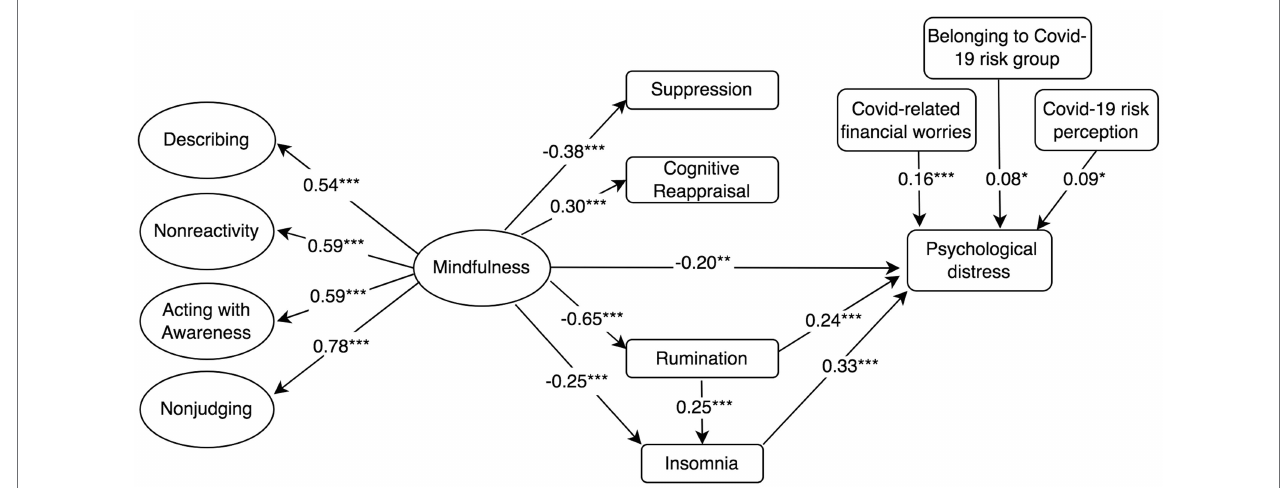
FIGURE 3 | Standardised mediation Model 3 of the effect of higher-order mindfulness on COVID-19-related psychological distress. Psychological impact of COVID-19 = IES-R, 22-item Impact of Event Scale-Revised; Rumination = RSS-SF, 10-item Rumination Response Scale-Short Form; Cognitive Reappraisal and Suppression = ERQ, 10-item Emotion Regulation Questionnaire; Insomnia = ISI, 7-item Insomnia Severity Index; and Mindfulness and facets = FFMQ-SF, 24-item Five-Facets Mindfulness Questionnaire-Short Form. † p < 0.10; * p < 0.05; ** p < 0.01; and *** p ≤ 0.001.